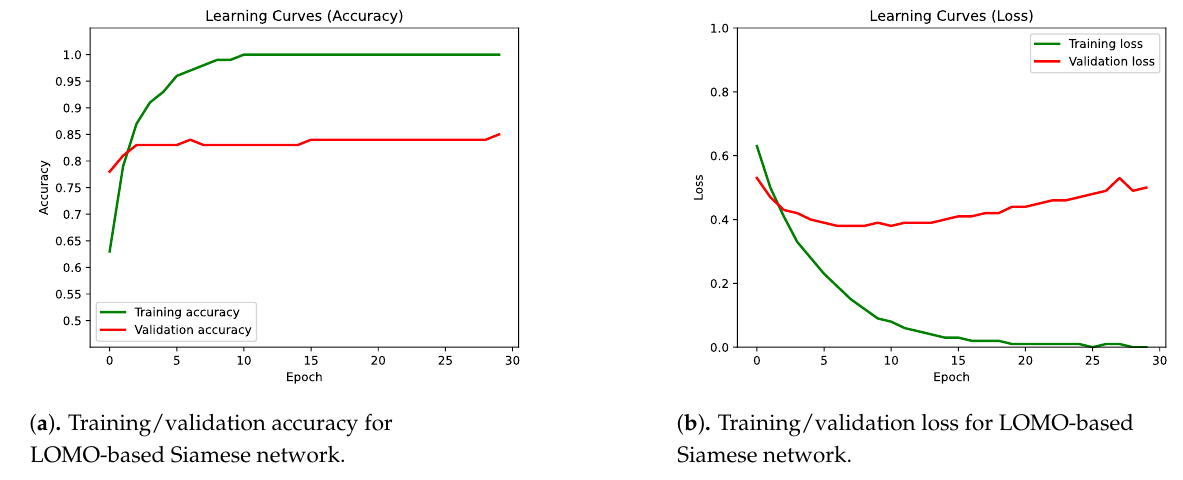
Figure 13. Siamese network training with